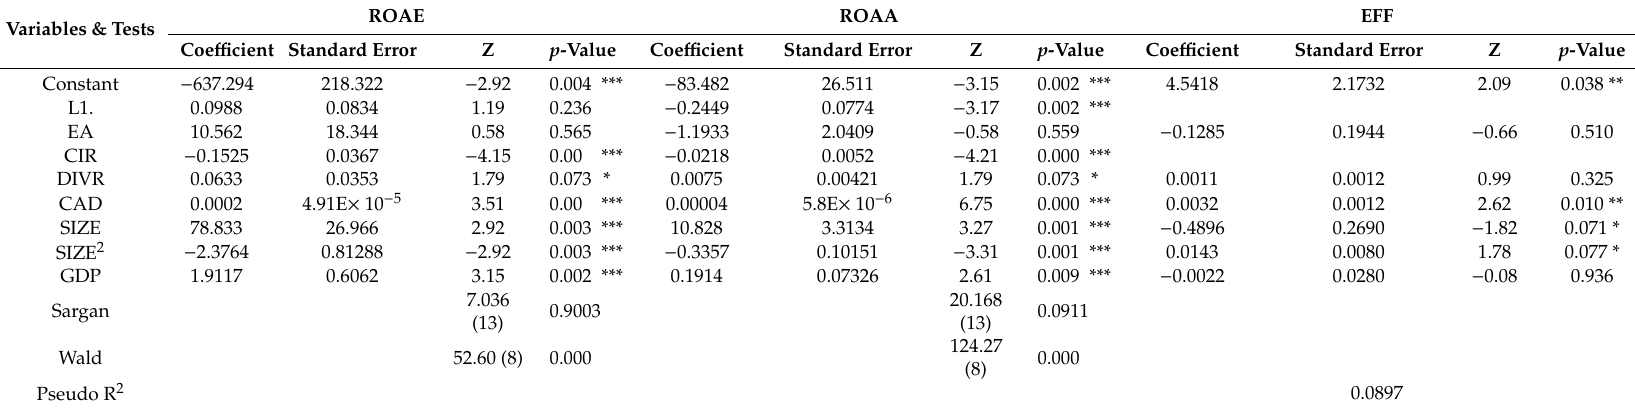
Table 5. Results of the Models formulated in Equations (1), (2) and (4): Estimation for the Banks in the Iberian Peninsula Sample considering the quadratic variable of the banks’